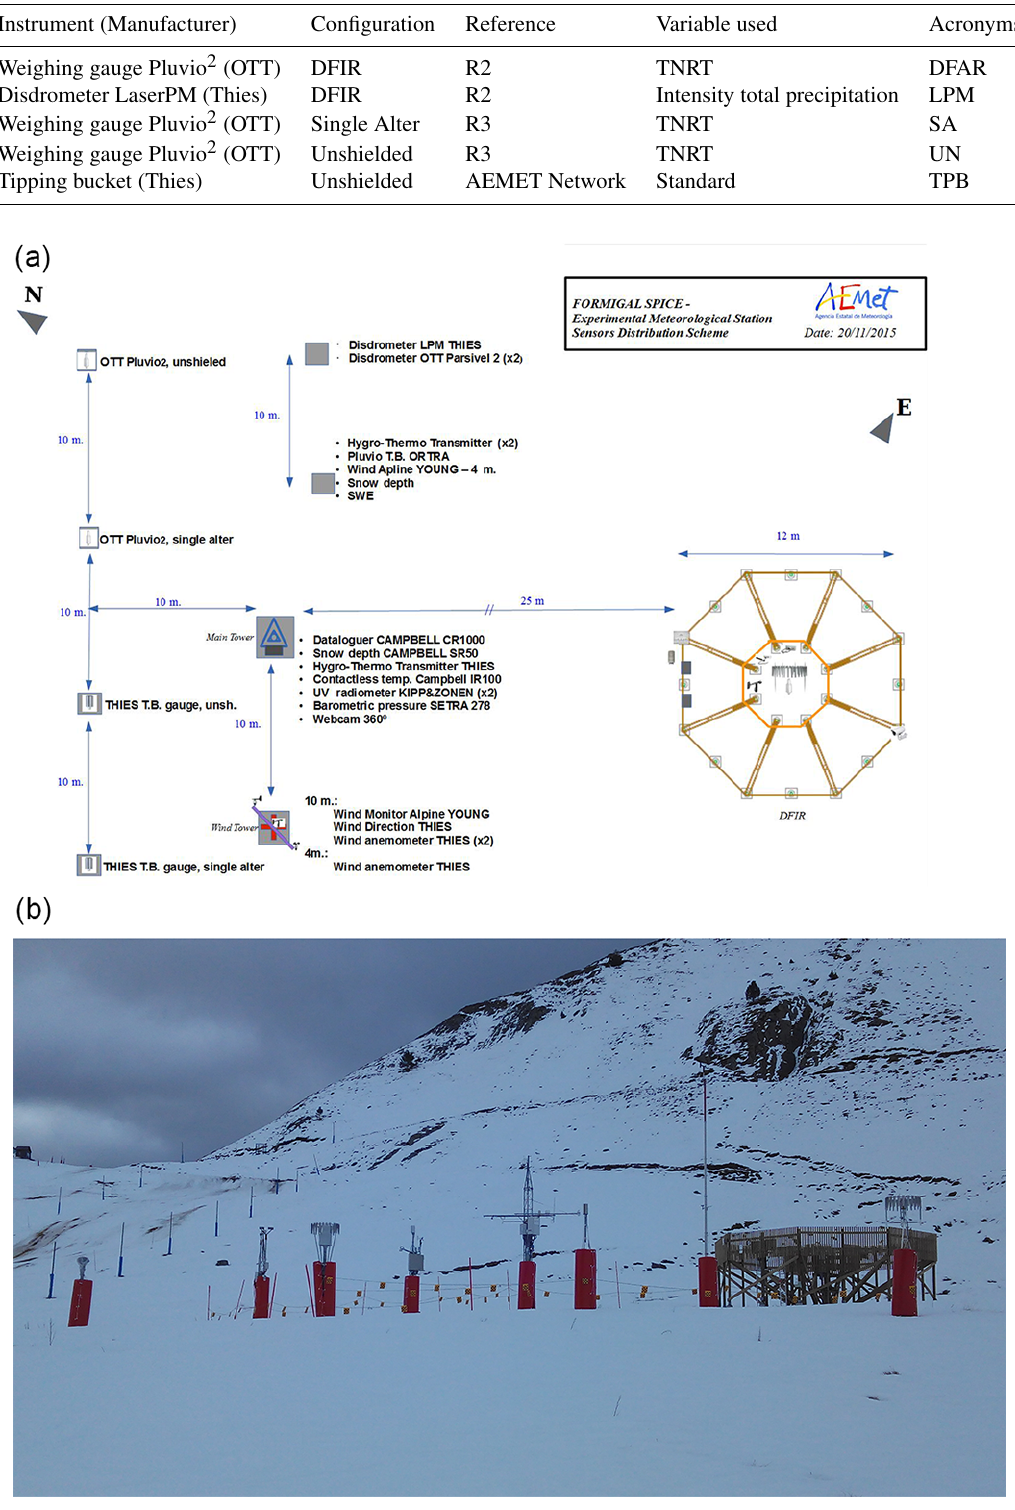
Figure 1. Layout (a) and photograph (b) of the Formigal–Sarrios test